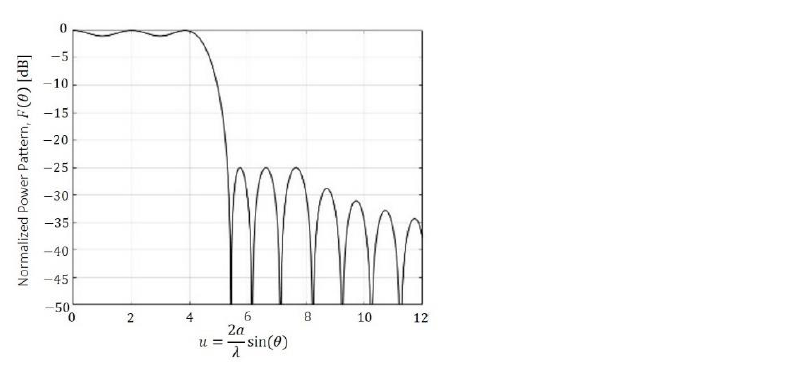
Figure 3. Shaped pattern with a ripple level of ± 0.5 dB and SLL = − 25 dB, generated by a pure-real distribution.